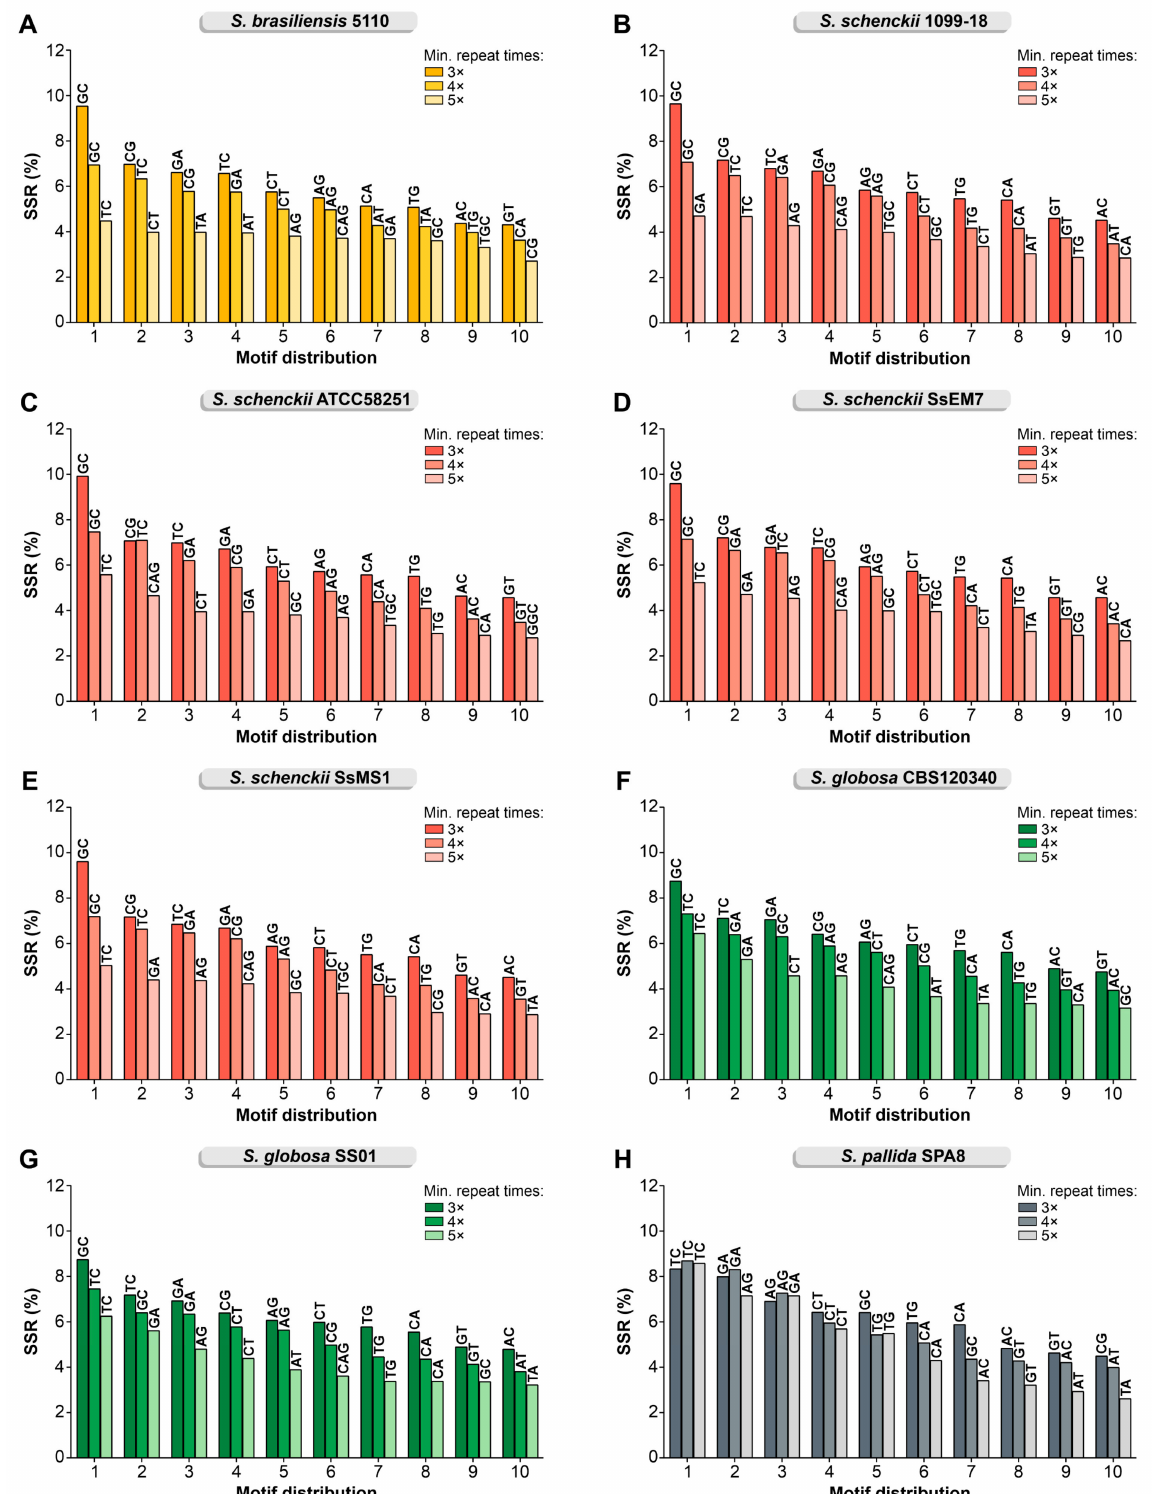
Figure 2. The top 10 motif distribution with a minimum of 3, 4, or 5 repeats and motifs of 2–10 bp identifies that GC/CG is the major SSR in Sporothrix genomes: ( A ) S. brasiliensis 5110; ( B ) S. schenckii 1099-18; ( C ) S. schenckii ATCC58251; ( D ) S. schenckii SsEM7; ( E ) S. schenckii SsMS1; ( F ) S. globosa CBS 120340; ( G ) S. globosa SS01; ( H ) S. pallida